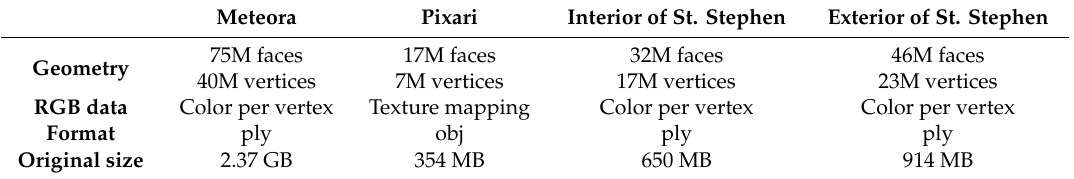
Table 1. Characteristics of the 3D models that are integrated in the web